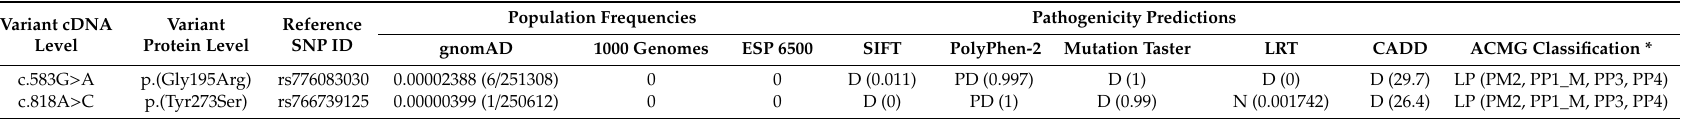
Table 2. Characteristics of RMND1 variants detected in this